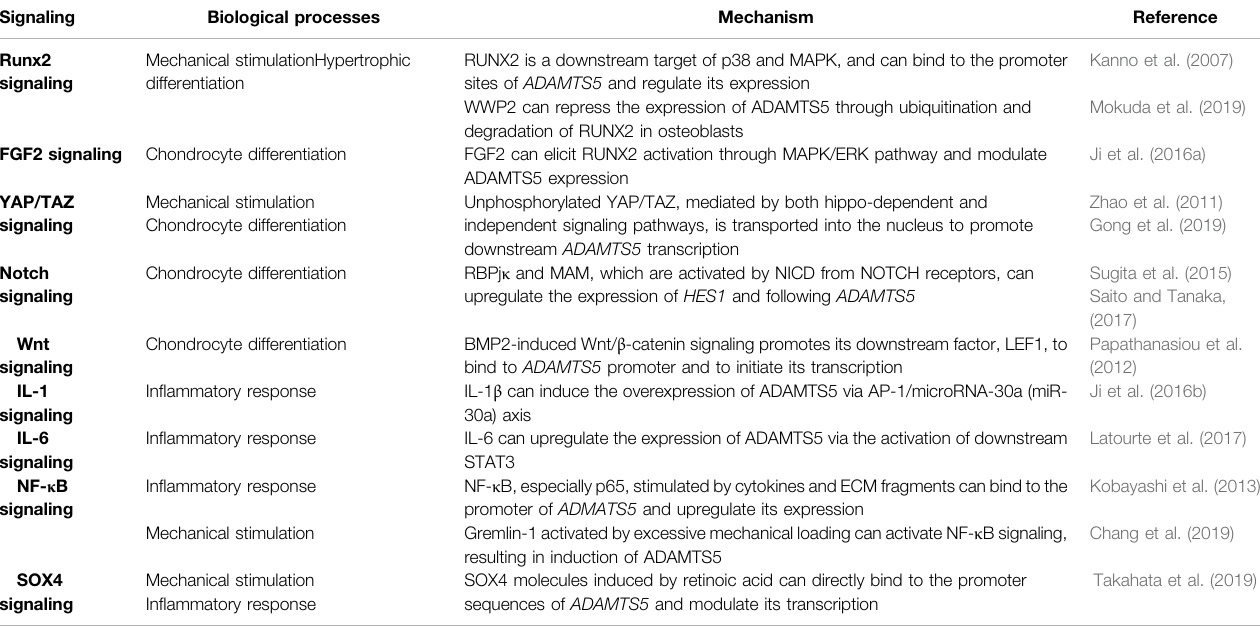
TABLE 1 | Signaling pathways that involve in ADAMTS5 regulation in the pathophysiological process of OA.